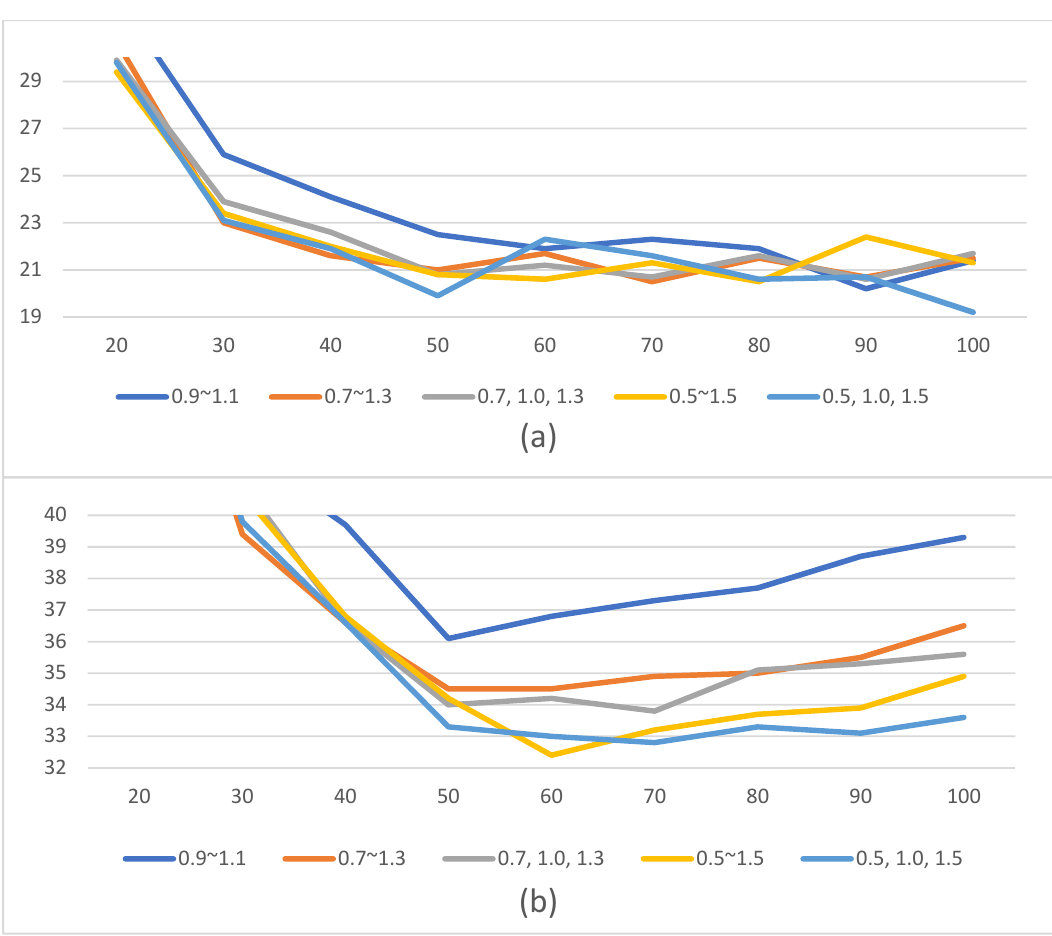
Figure 7. Validation loss of WSJ ( a ) and LibriSpeech ( b ) databases by epoch. The horizontal axis denotes the number of epochs and the vertical axis denotes validation loss.